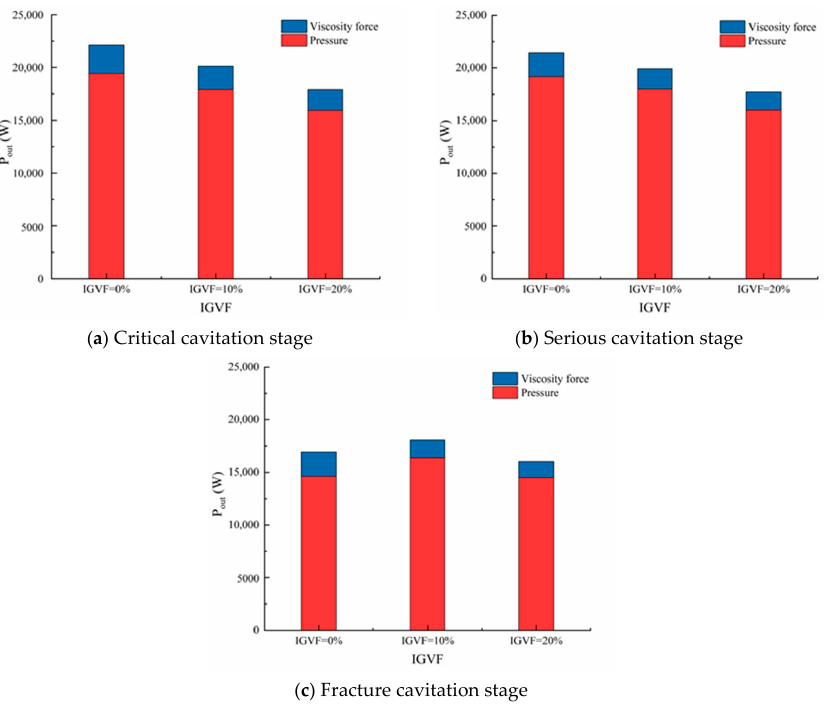
Figure 9. The output power distribution of the impeller under different IGVFs at each cavitation stage.